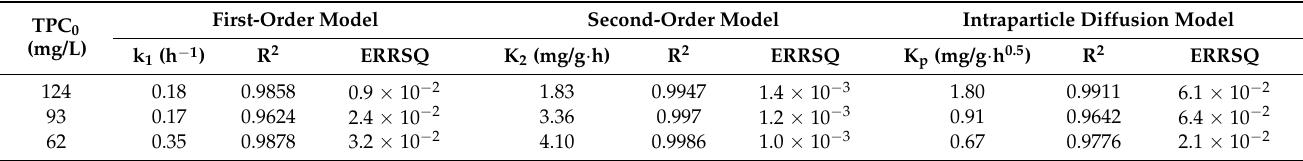
Figure 13. Pseudo-second-order model at pH = 5.0, T = 295 K, and Ox-AC/Cu/Cu 2 O/CuO dose of 1% by wt. Table 4. Kinetic parameters, ERRSQ, and regression coefficients for the adsorption of TPC by Ox-AC/Cu/Cu 2 O/CuO at different initial TPC concentrations.